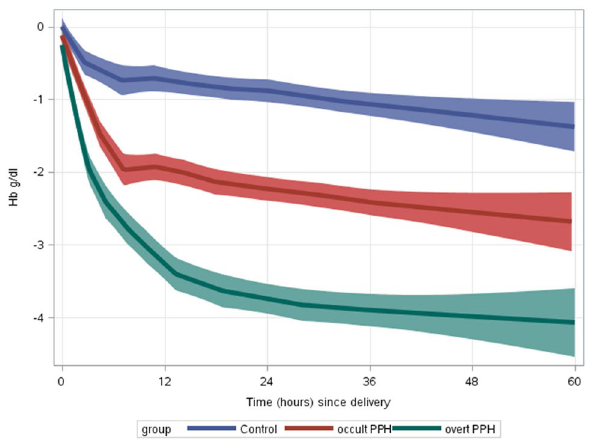
Figure 2. Hemoglobin drop during the immediate postpartum period. LOESS smooth curve (smoothing parameter 0.6) with 95% confidence interval of the mean hemoglobin (Hb) drop by time (hours) from delivery in women monitored due to overt postpartum hemorrhage (PPH), occult PPH or other indications (control). Correction for blood transfusion was made as described in the in the “Methods”